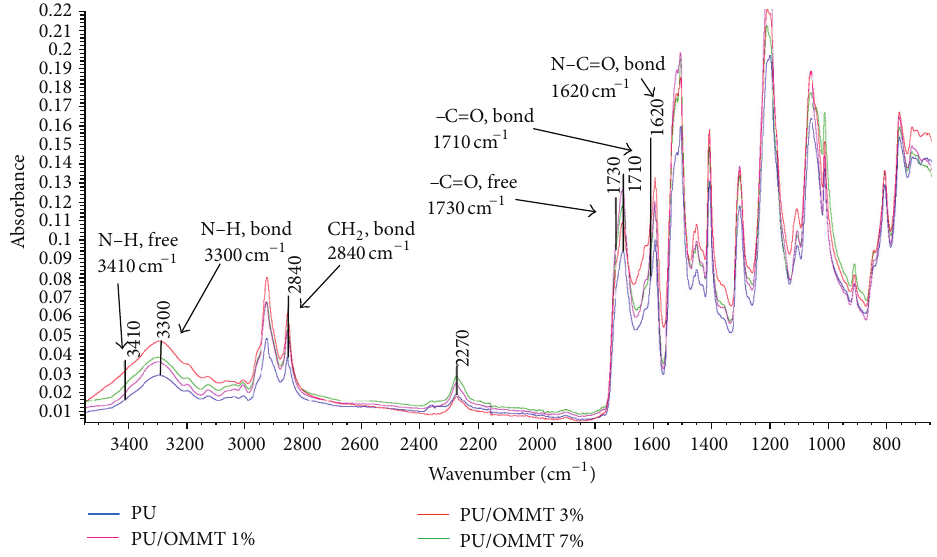
Figure 9: FTIR-ATR spectra of PU and PU/OMMT